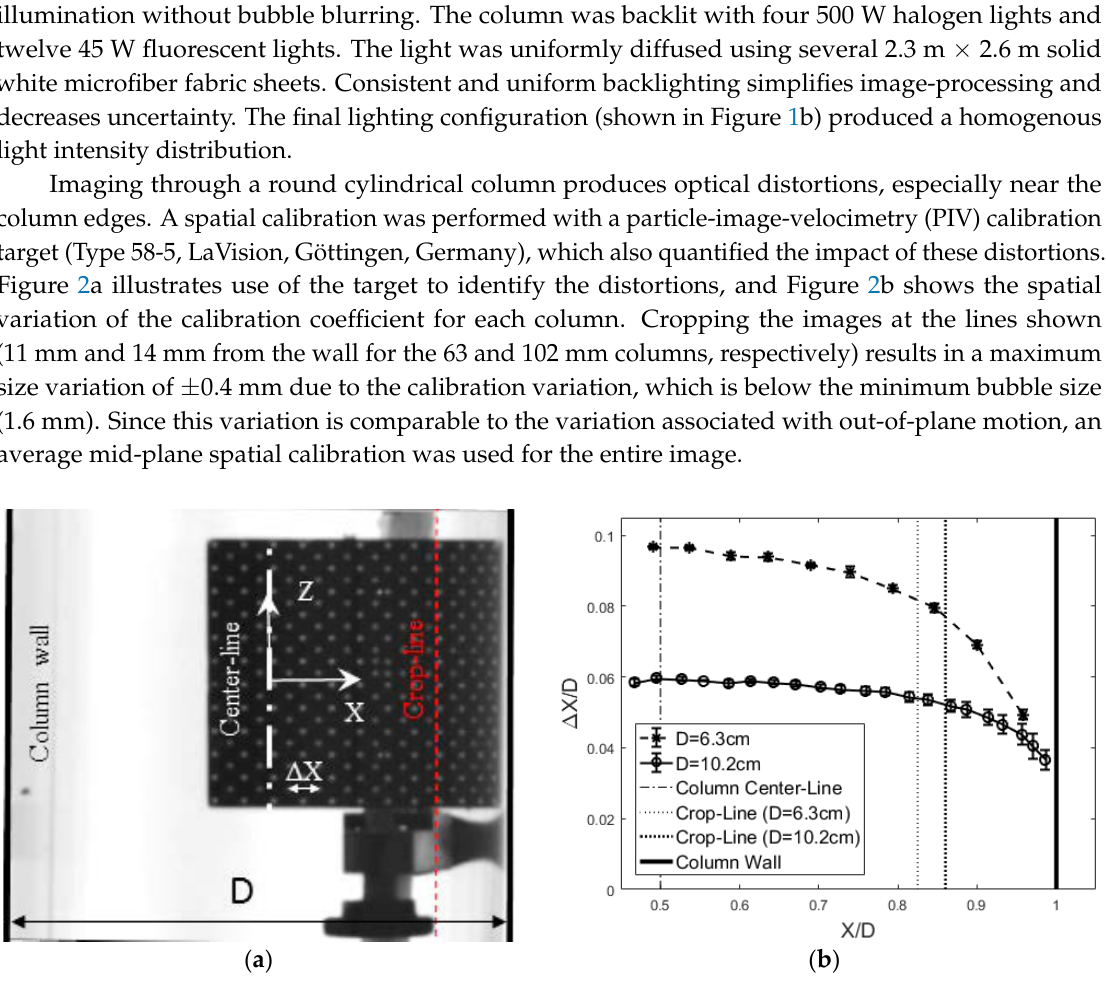
Figure 2. ( a ) Effect of column curvature on spatial calibration, Δ X = 5 mm, D = 102 mm. ( b ) Spatial variation of the calibration coefficient across the column mid-plane.